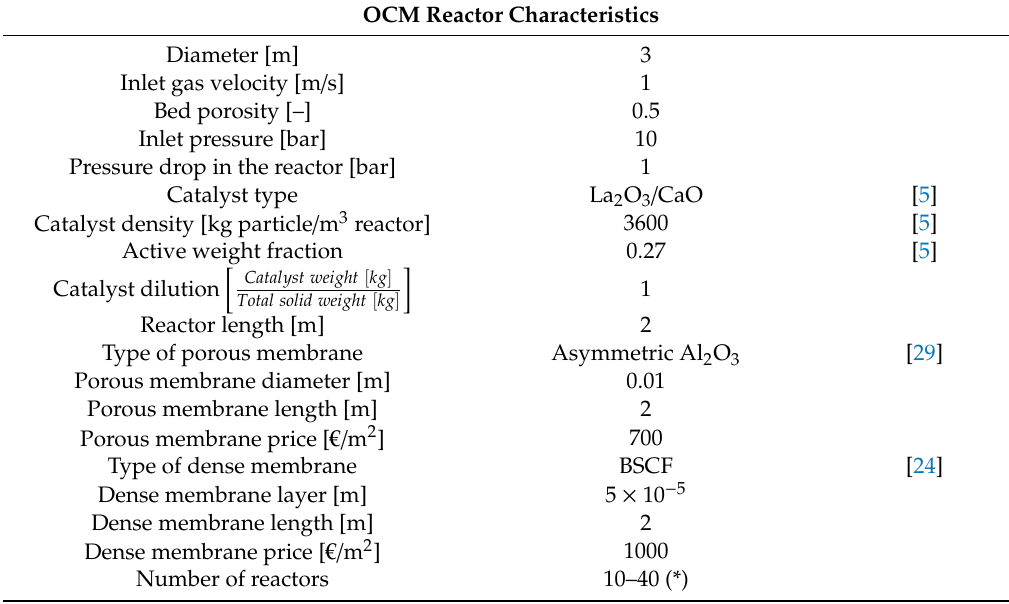
Table 4. Characteristics assumed for the simulation of the 1D oxidative coupling of methane (OCM) reactor